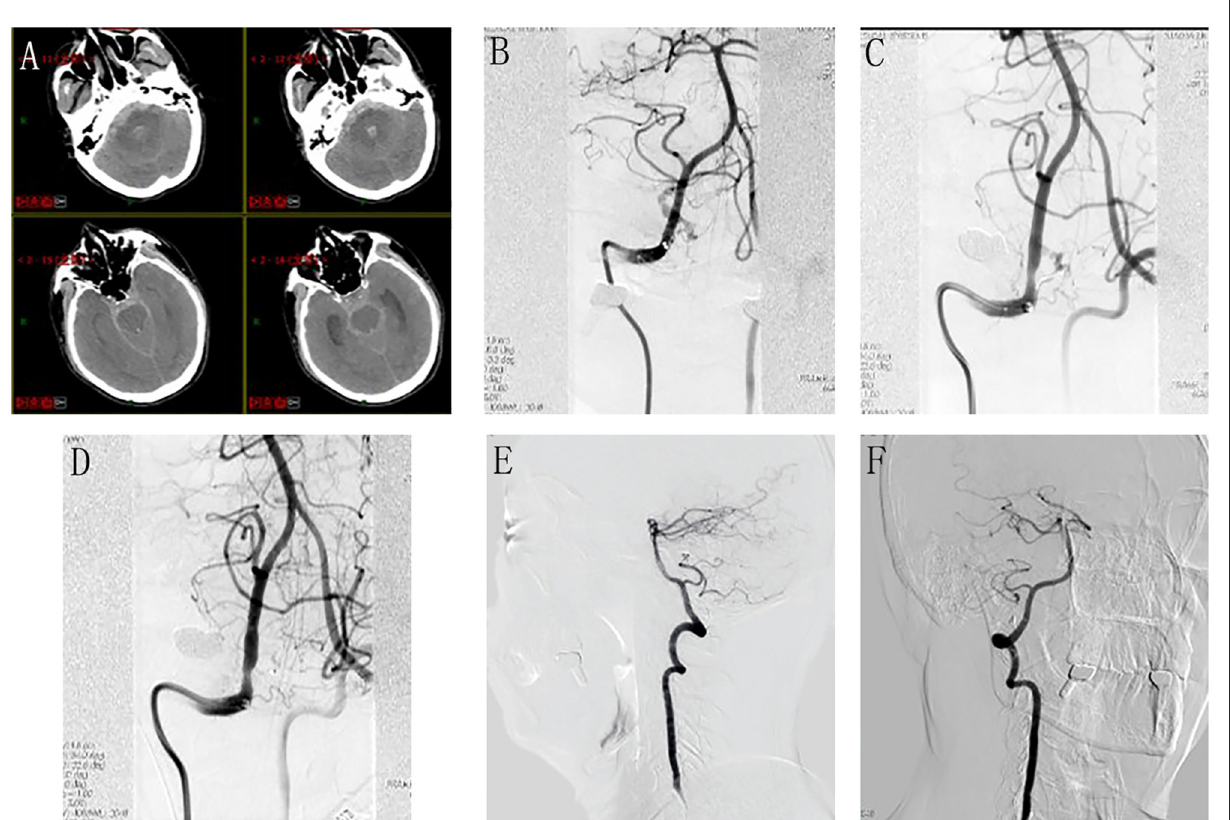
FIGURE2 Perioperative neuroimages of Case 13. Emergent cranial CT revealed diffuse SAH and 4th ventricular hematoma (A) . Emergent cerebral DSA revealed a DAVF located at the foramen magnum supplied by the meningeal branch of the right VA, draining into the enlarged tortuous medullary vein (B) . During the procedure, the microcatheter tip was advanced to reach the optimal position (C) ; the injection of Onyx was continued until the DAVF was completely obliterated (D) . Follow-up angiography at 6 months did not reveal any fistula residual or recurrence (E) , lateral view; (F) , anteroposterior